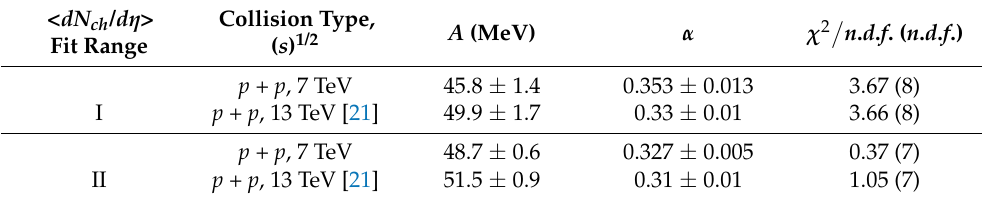
Table 4. Parameters extracted from minimum χ 2 fits using the simple power function > α of the T versus < dN T = A · < dN ch ch / d η > dependencies in Figure 3b in the whole < dN ch / d η > d η region (I), and in the whole region excluding the first data point (II) with < dN ch / d η > = 2.26 ± 0.12 and < dN ch / d η > = 2.55 ± 0.04 in proton-proton collisions at ( s ) 1/2 = 7 and 13 TeV, respectively. The corresponding data extracted from [21] for proton-proton collisions at ( s ) 1/2 = 13 TeV are shown for